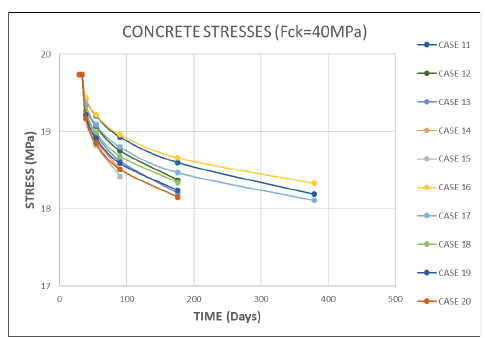
Figure 15. C40 Concrete stresses evolution by creep.